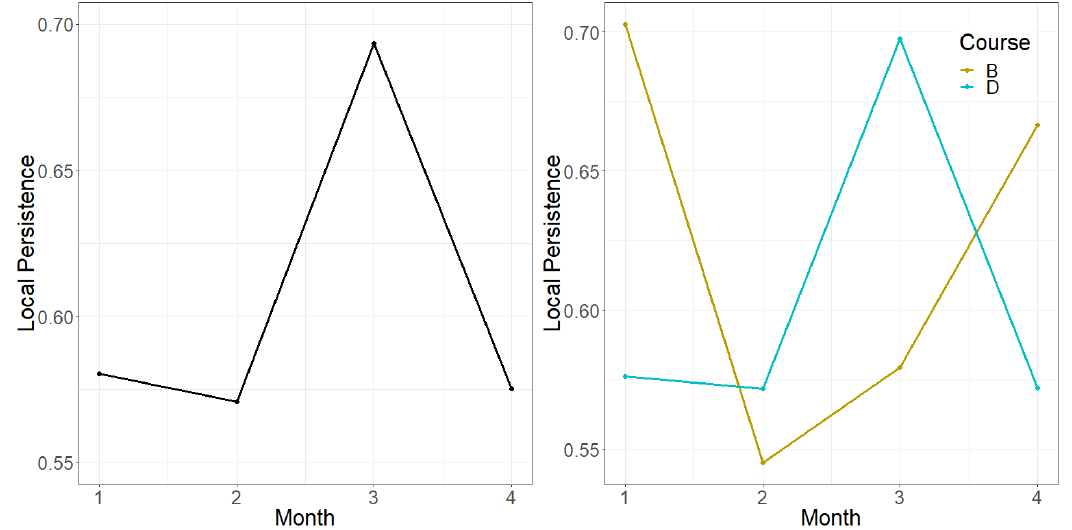
Figure 4. ( a: left ) Evolution of the local persistence of students who engage all months for all courses together and ( b: right ) for each individual course.